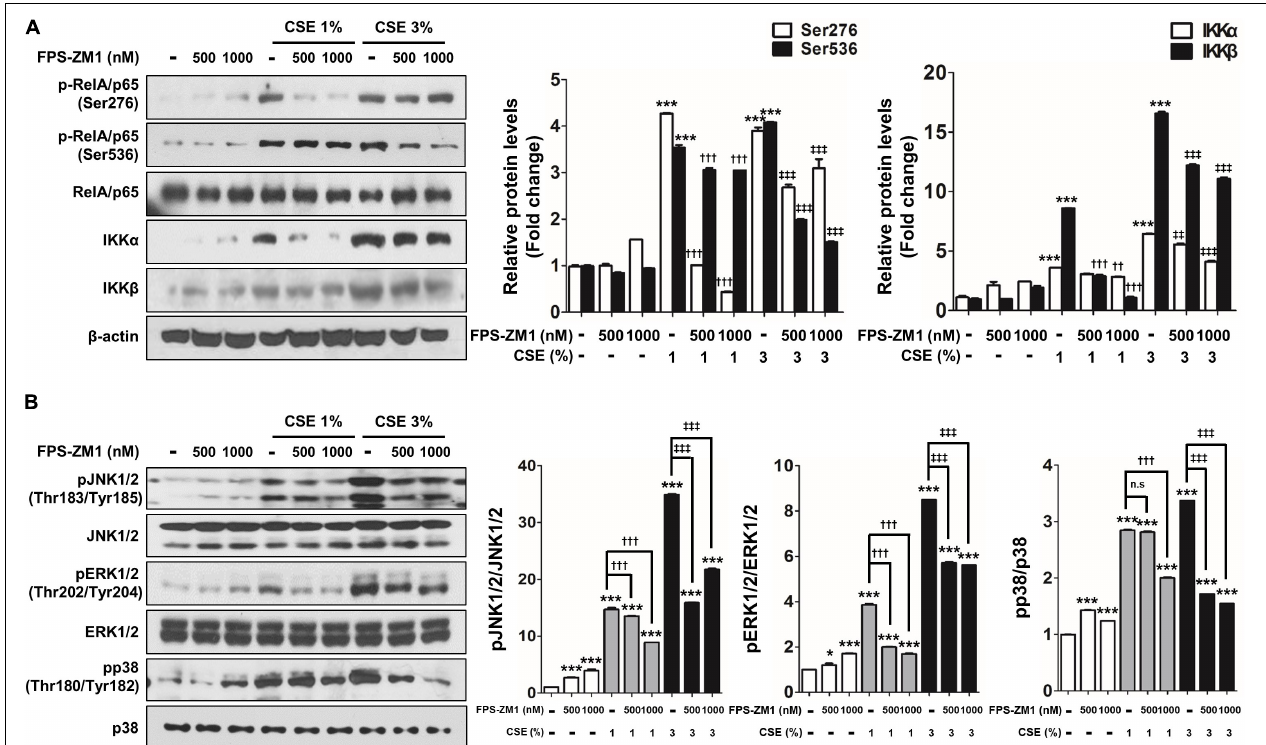
FIGURE 6 | The effect of FPS-ZM1 treatment on CSE-induced activation of DAMP signaling in human alveolar epithelial cells. After exposure to CSE for 8 h in the presence or absence of FPS-ZM1 for 24 h, western blot analysis was performed in cell lysates to confirm the reverse effects of FPS-ZM1 on CSE-induced activation DAMP signaling. (A) Protein lysates of isolated A549 cells were subjected to western blotting with either anti-p-RelA/p65 (Ser276), anti-p-RelA/p65 (Ser536), anti-IKK α , or anti-IKK β antibodies for the assessment of NF- κ B activity. RelA/p65 and β -actin were visualized as a loading control. (B) Equal protein lysates were subjected to western blotting with either anti-pJNK1/2 (Thr183/Tyr185), anti-pERK1/2 (Thr202/Tyr204), or anti-pp38 (Thr180/Tyr182) antibodies for the assessment of MAPK activity. JNK1/2, ERK1/2, and p38 were visualized as a loading control. The corresponding density ratio was determined by the average intensity of the bands. All values are average ± SE. CTL, no treatment; n.s, not significant. ∗ p < 0.05 and ∗∗∗ p < 0.001 vs. CTL; †† p < 0.01 and ††† p < 0.001 vs. 1% CSE treatment; ‡‡ p < 0.01 and ‡‡‡ p < 0.001 vs. 3% CSE